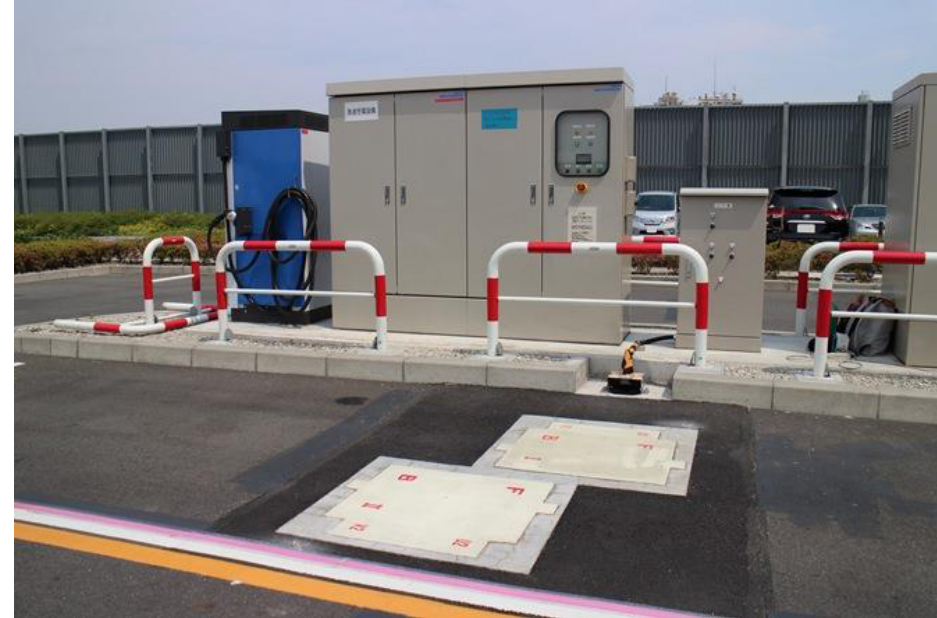
Figure 5. Transmit equipment of 85 kHz band 44 kW wireless rapid charging system.